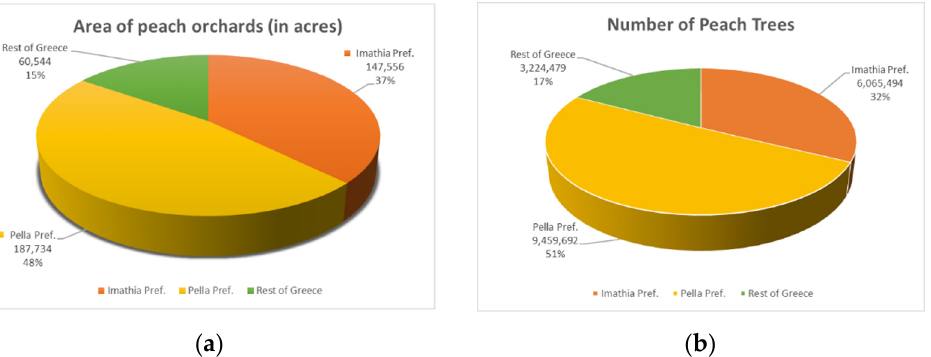
Figure 2. Data concerning peach production in the Prefectures of Imathia and Pella in relation to the rest of Greece: ( a ) Area of peach orchards in acres and ( b ) the number of cultivated peach trees for the year 2018 (source: Hellenic Statistical Service).